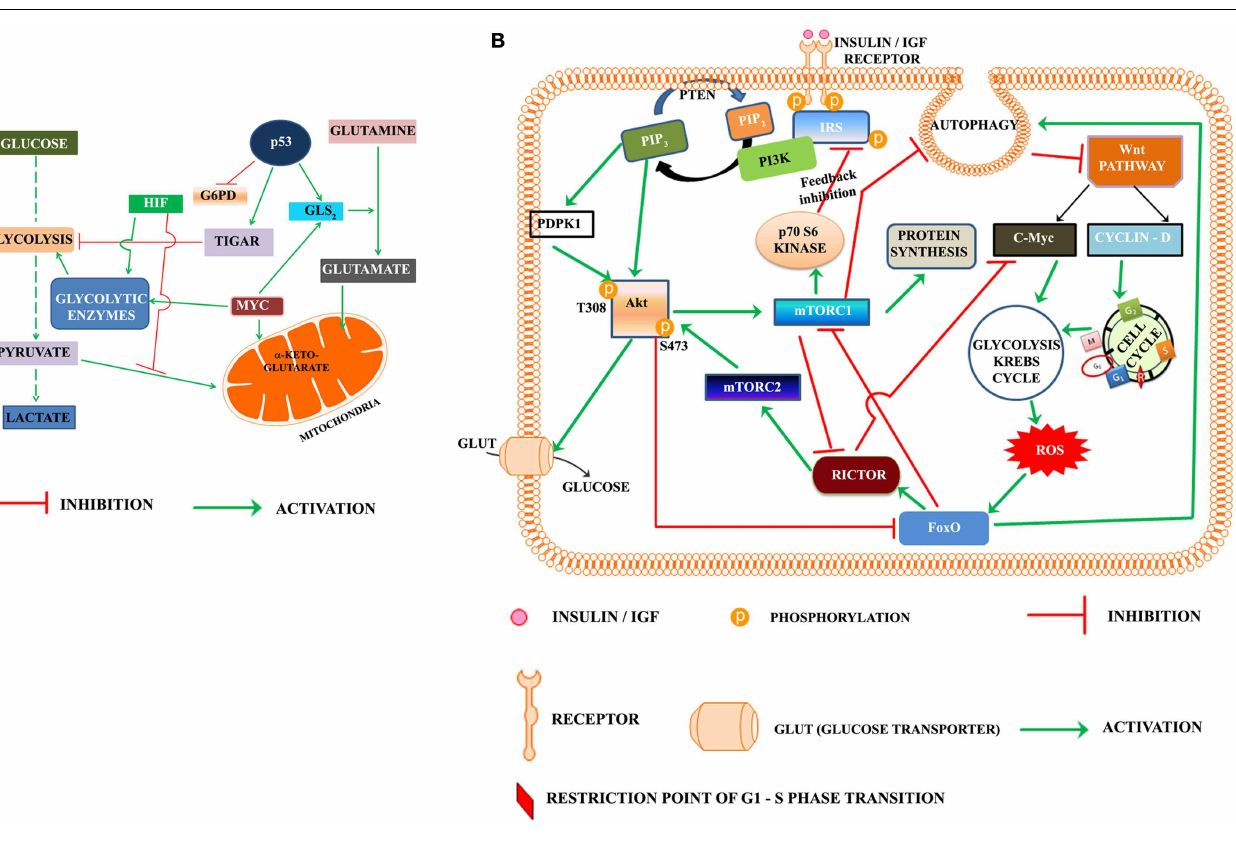
activation in cancer cells leads to the production of reaction oxygen species (ROS), which activate the FoxO. FoxO is the transcription factor of rictor, one of the key components of mTORC2 recognized as the kinase phosphorylating Akt on S473. Rictor also inhibits c-Myc, which